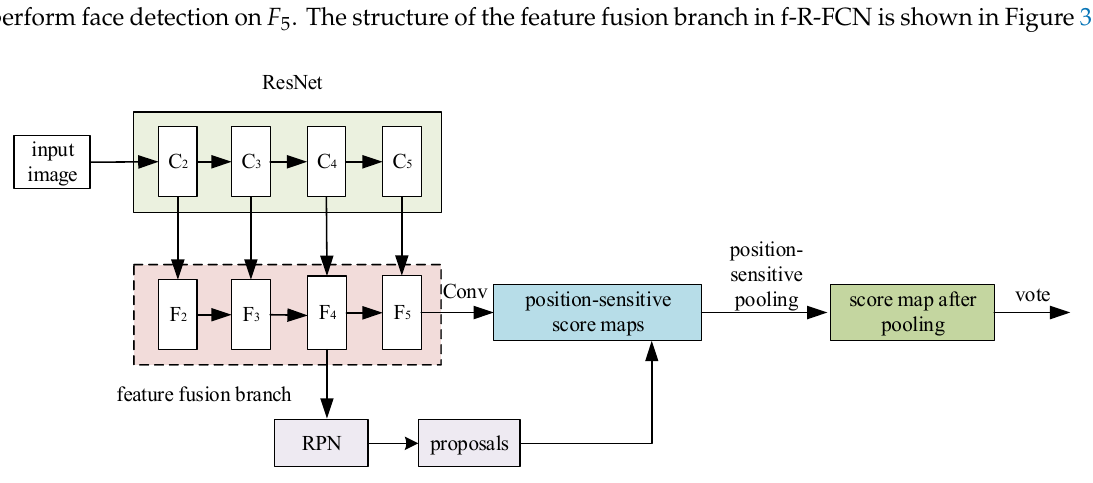
Figure 3. Structure of feature fusion branch in R-FCN with a feature fusion branch (f-R-FCN).